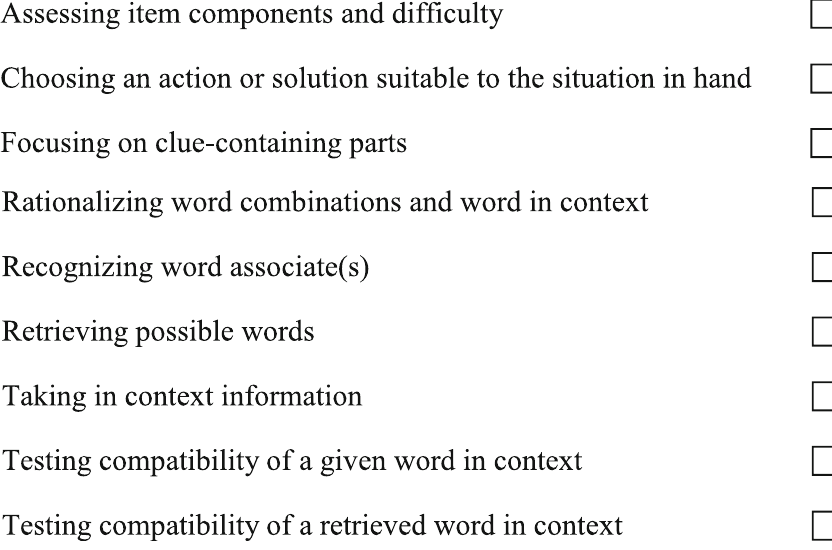
Table 3 Checklist for ConCloze test-taking processes and